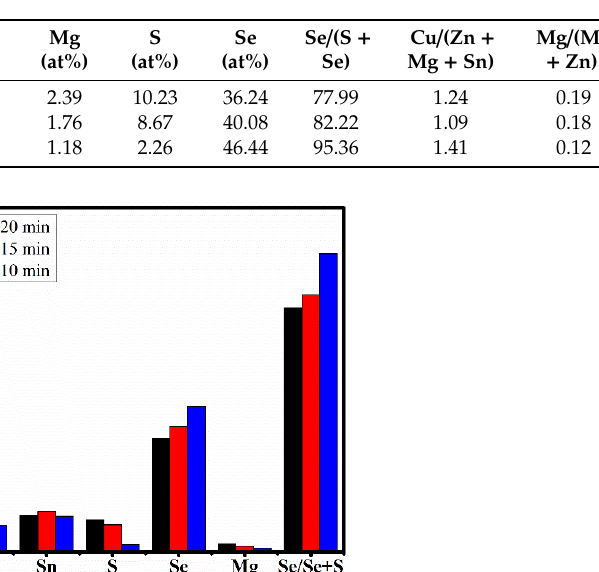
Table 5. EDS results of the CMZTSSe films annealed for di ff erent times from 10 to 20 min.